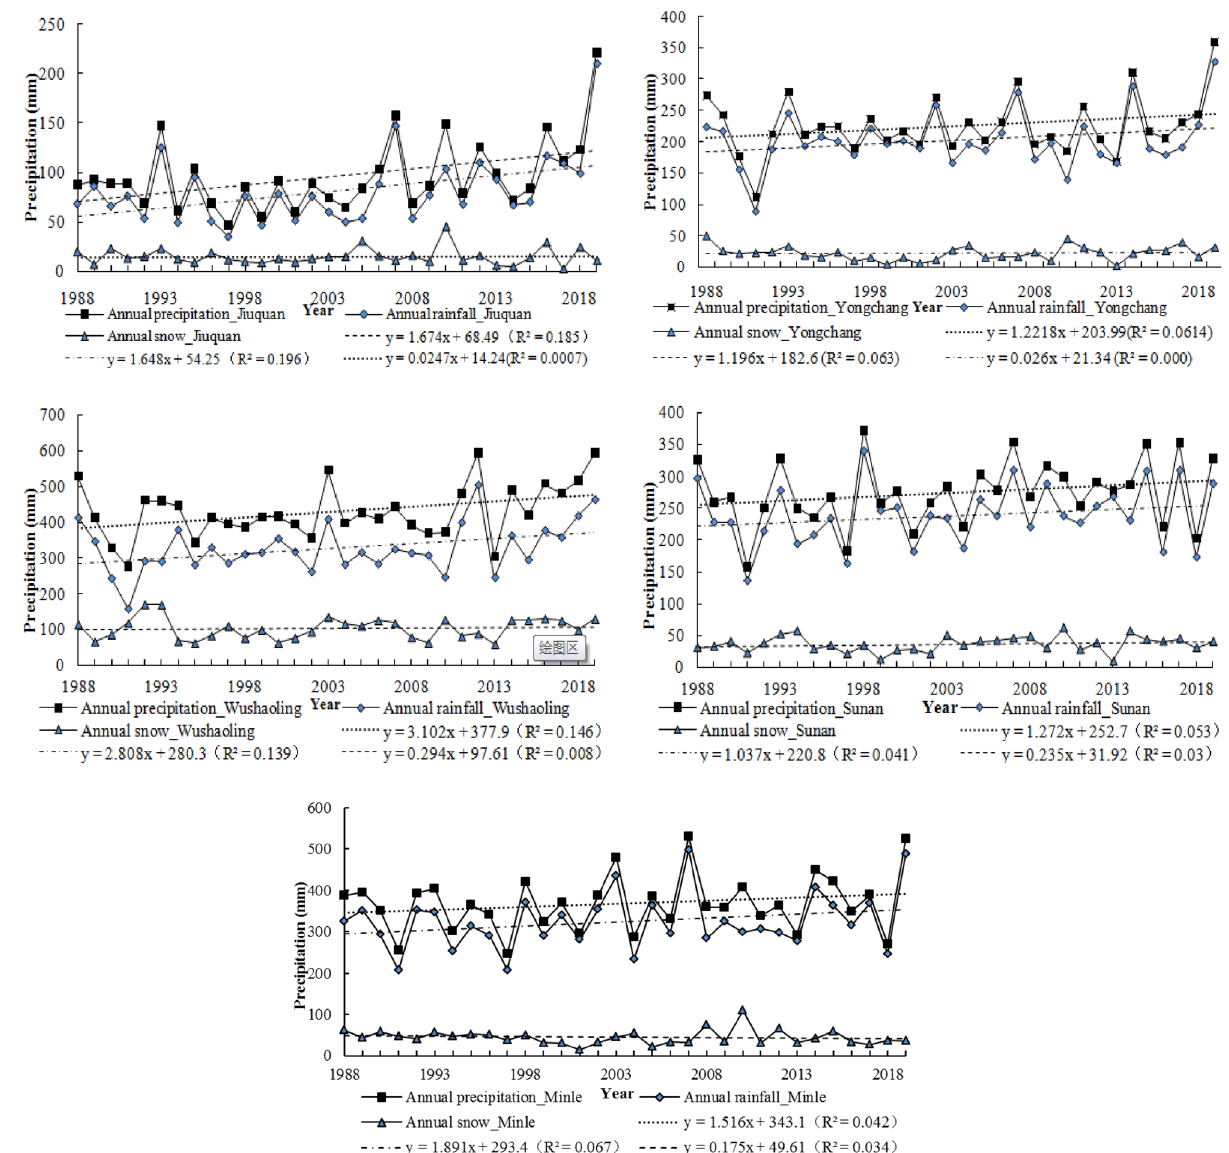
Figure 2. Trends of Annual precipitation, Annual rainfall, Annual